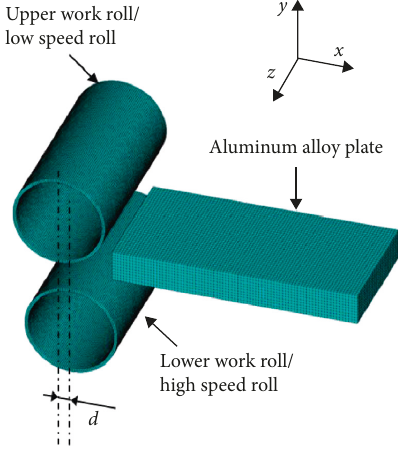
Figure 3: Finite element model.